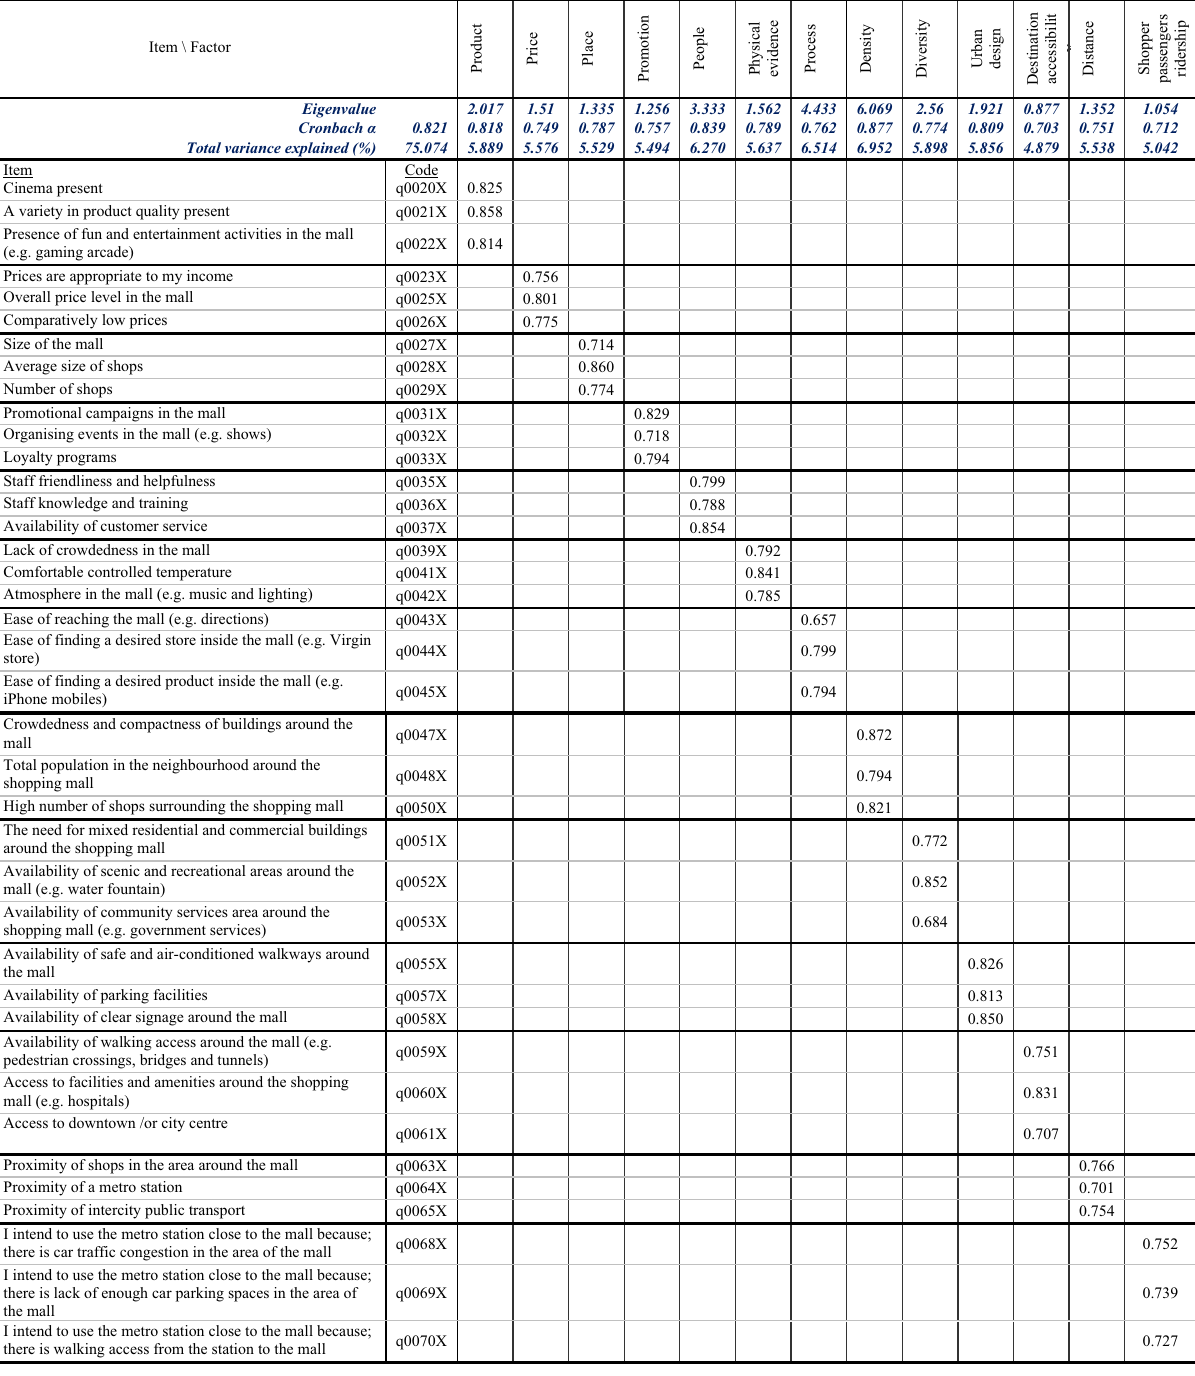
Table 2 TOSMD factors impacting shopper passenger ridership Item \